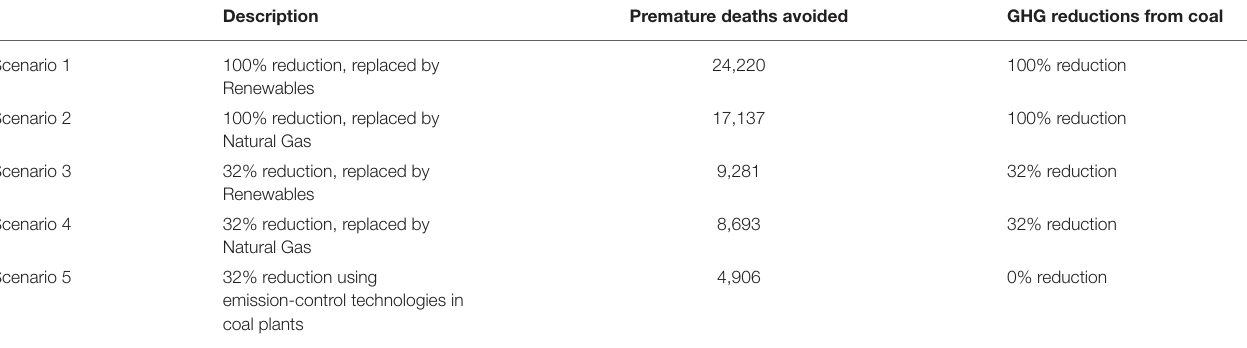
TABLE 1 | Energy scenarios’ reductions of PM 2.5 , NO x , and SO 2 , their corresponding health results compared to Business-as-usual, and greenhouse gas